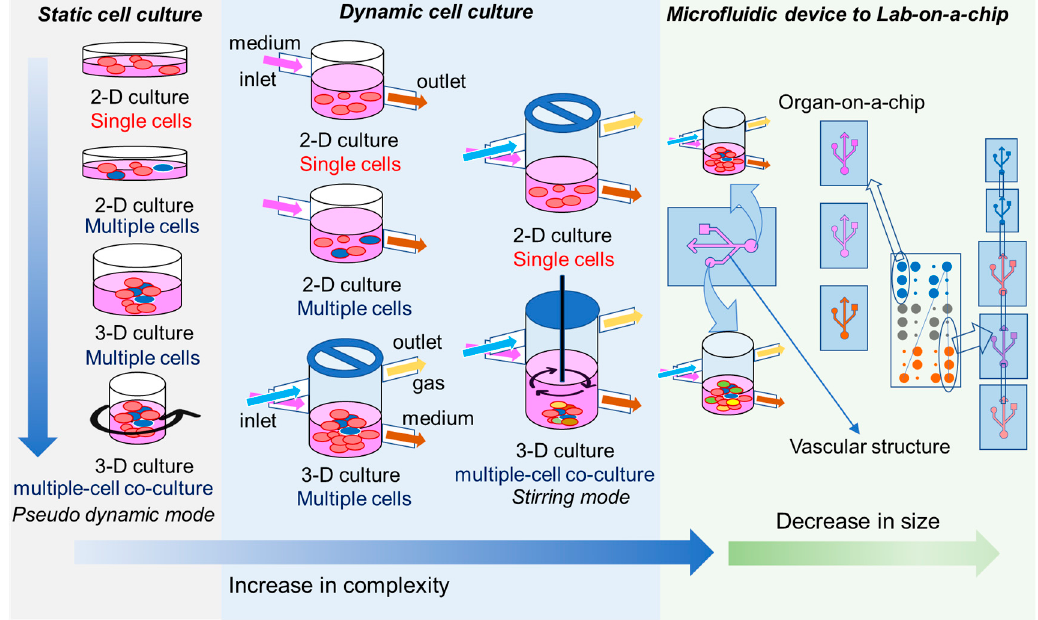
Figure 2. Evolution of in vitro toxicity models.